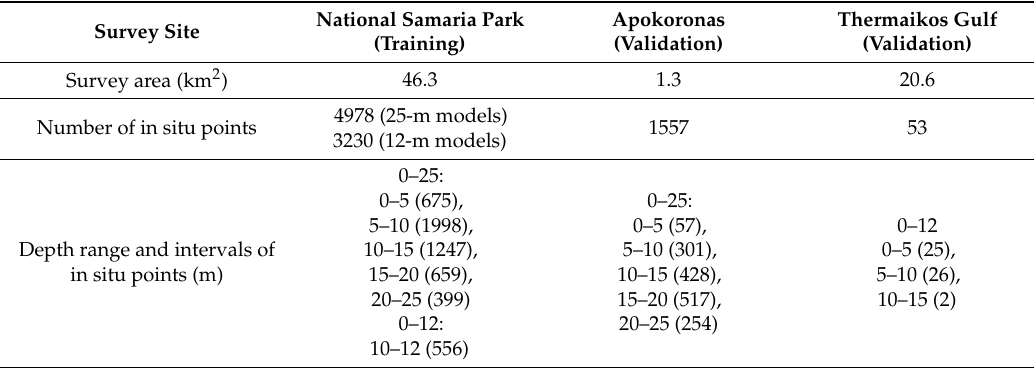
Table 1. Survey area and number of related in situ points used for training and validation of the satellite-derived bathymetry models. The Thermaikos Gulf has a lower number of validation points as the initially available dataset is much smaller in comparison to that of